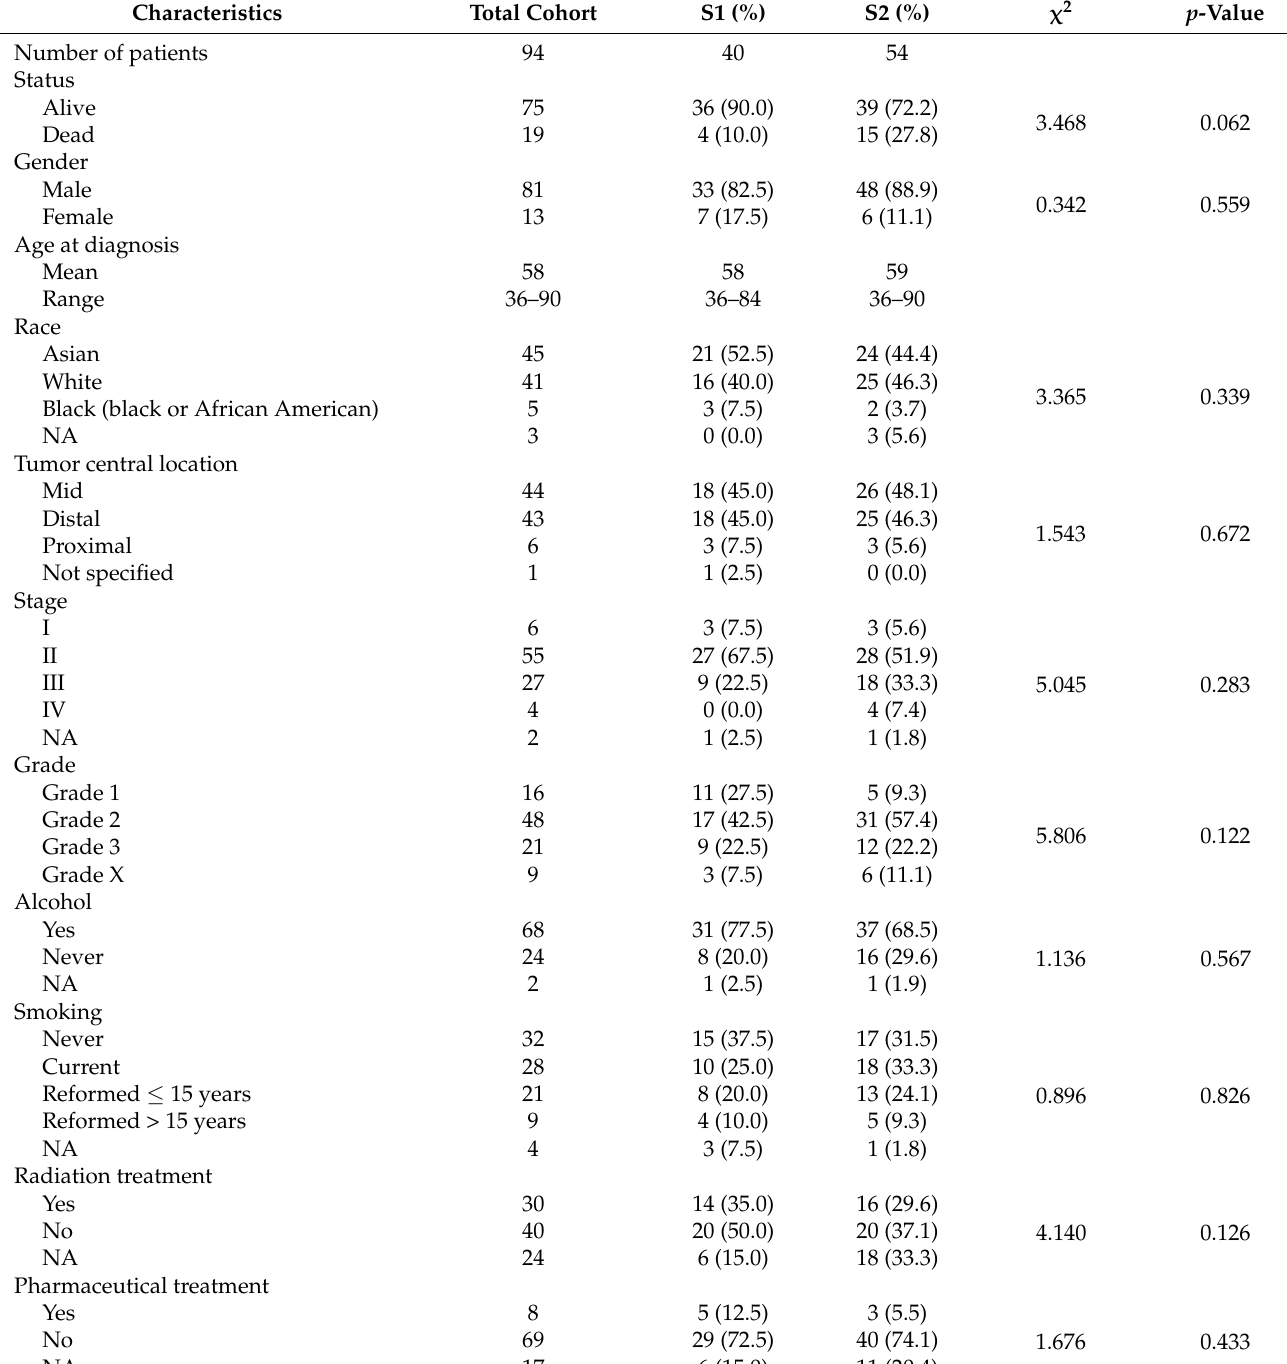
Table 1. Clinical characteristics of TCGA-ESCC